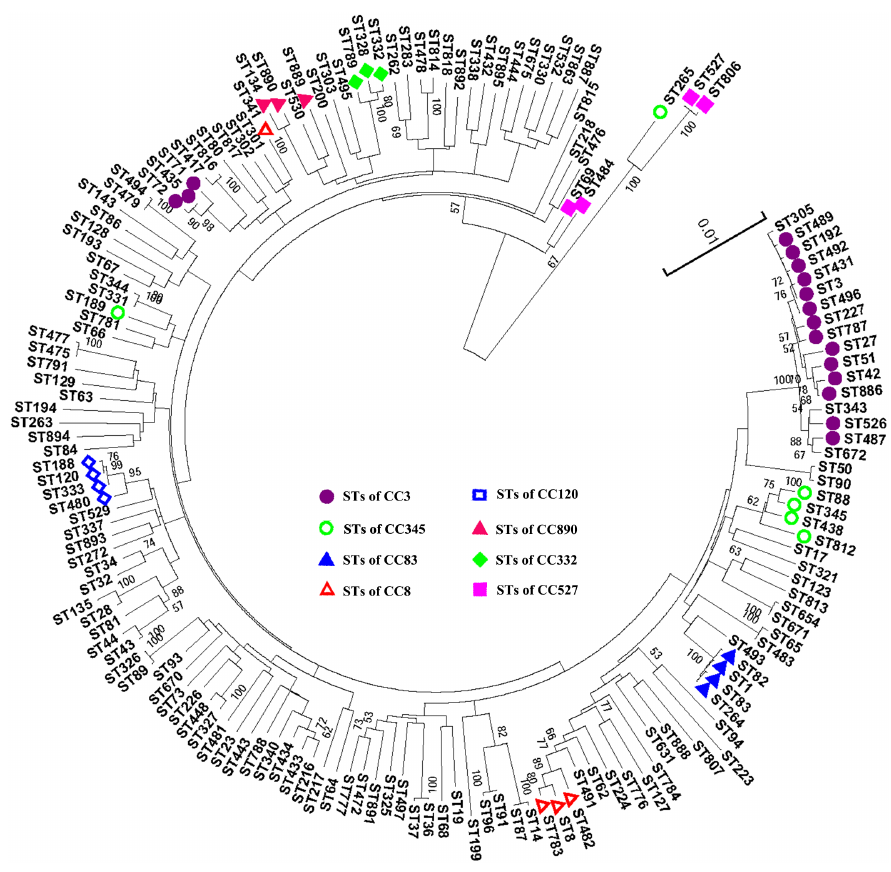
Figure 2. An ME tree was constructed using the concatenated sequences of the seven loci of each of the 161 STs obtained in this study. Squares, circles, and triangles with different shading represent the eight clonal complexes observed via eBURST. The scale represents the evolutionary distance, and bootstrap values over 50% are shown on the branches.